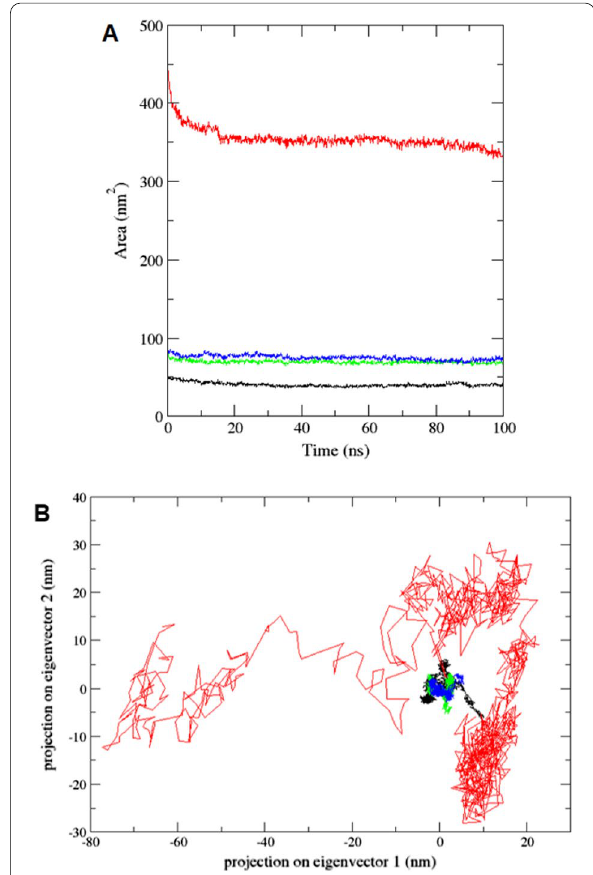
Fig. 6 Root-mean-square deviation and radius of gyration plots for the individual components of the CENP-HIKM sub-complex. A shows the RMSD evaluation of the sub-complex components, while ( B ) displays the Rg plot for each protein making up the sub-complex. Trajectories of the CENP-H, CENP-I, CENP-K, and CENP-M are colored in black, red, green, and blue, respectively